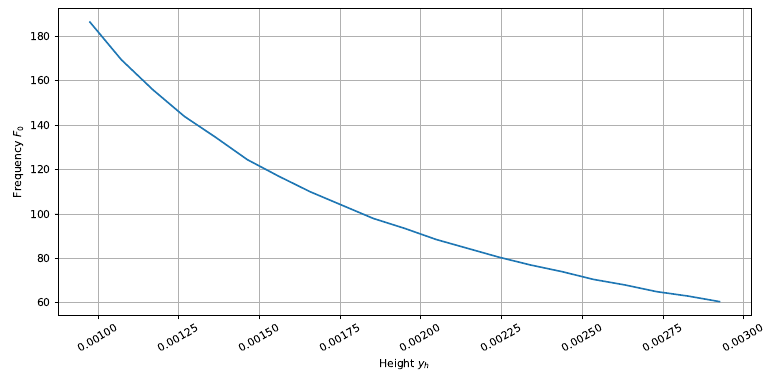
Figure 7. Dependence of F act